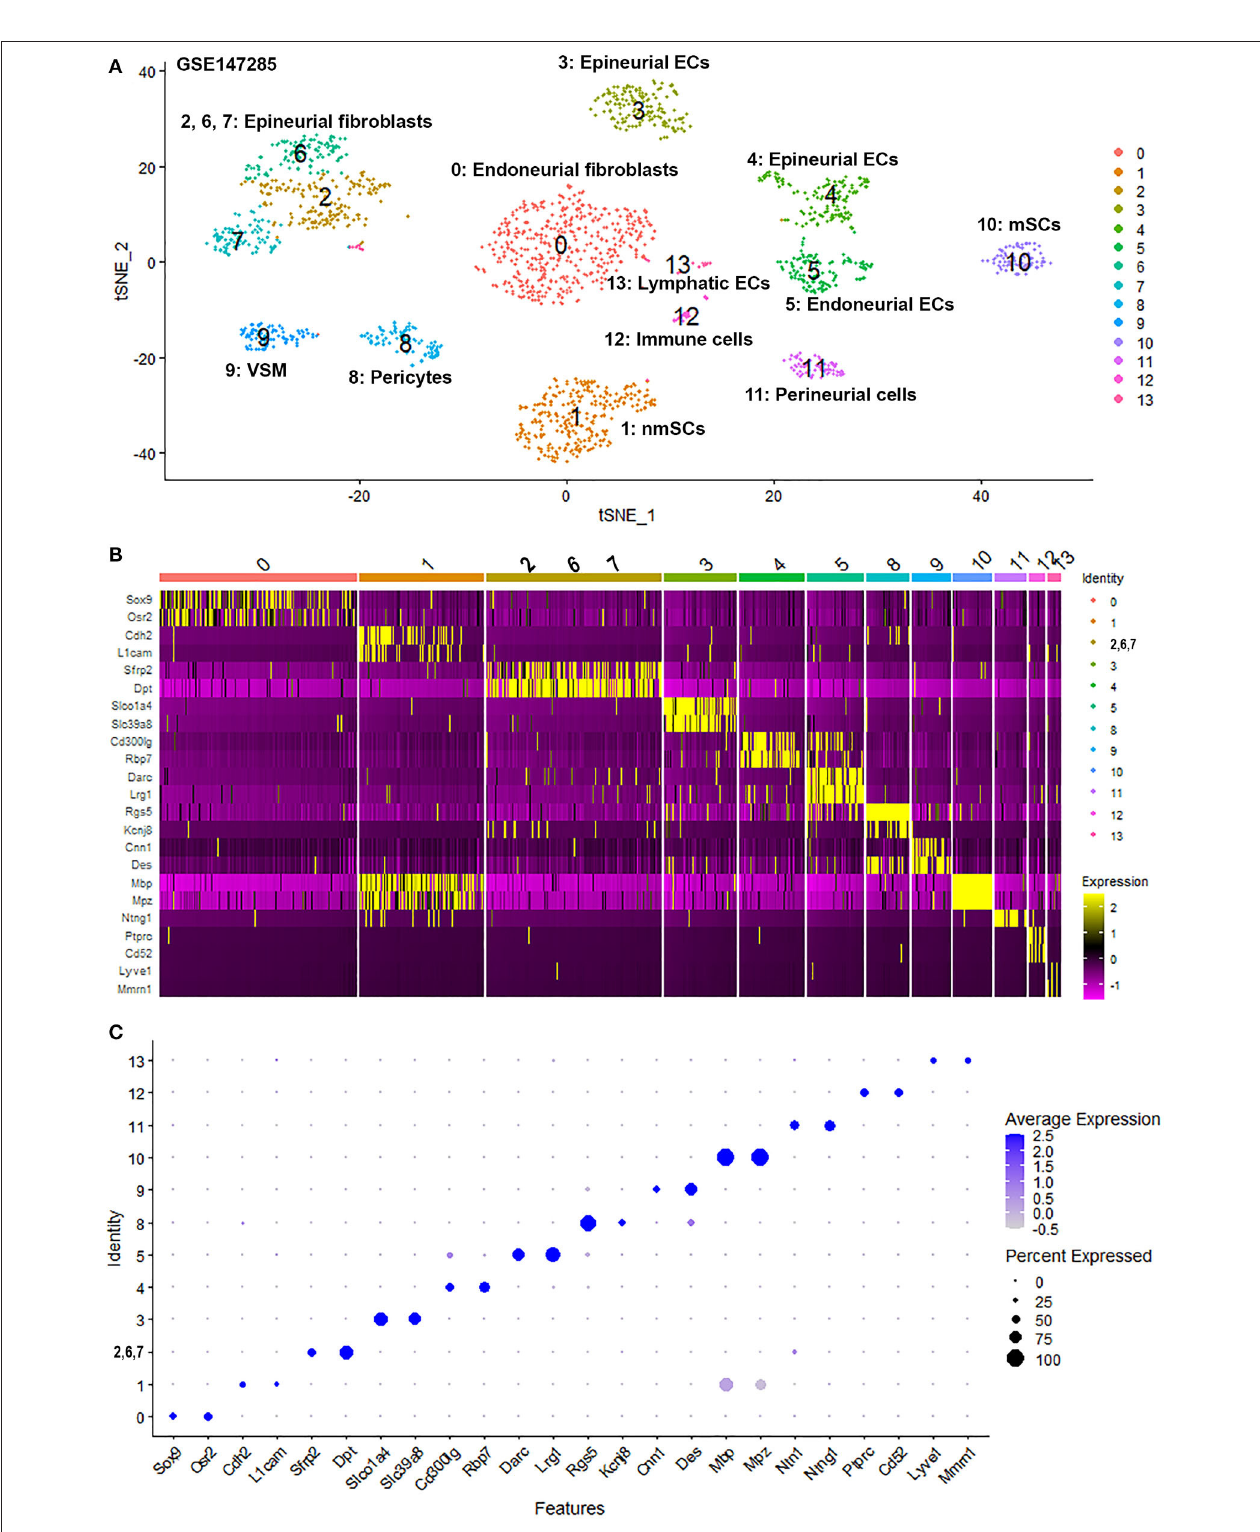
FIGURE 1 | Single cell transcriptomics (GSE147285) defines cellular phenotypes in intact mouse sciatic nerve. (A) tSNE visualization of cell clusters in intact mouse sciatic nerve. 0: Endoneurial fibroblasts; 1: Non-myelinating Schwann cells (nmSCs); 2, 6, 7: Epineurial fibroblasts; 3, 4: Epineurial endothelial cells; 5: Endoneurial endothelial cells; 8: Pericytes; 9: Vascular smooth muscle (VSM) cells; 10: Myelinating Schwann cells (mSCs); 11: Perineurial cells; 12: Immune cells (resident macrophages, mast cells, T/NK cells); 13: Lymphatic endothelial cells. (B) Heat map of selected marker genes for each cell cluster, cluster 2, 6, and 7 has been merged. (C) Dot plot of selected marker genes for each cell cluster, cluster 2, 6, and 7 has been merged.